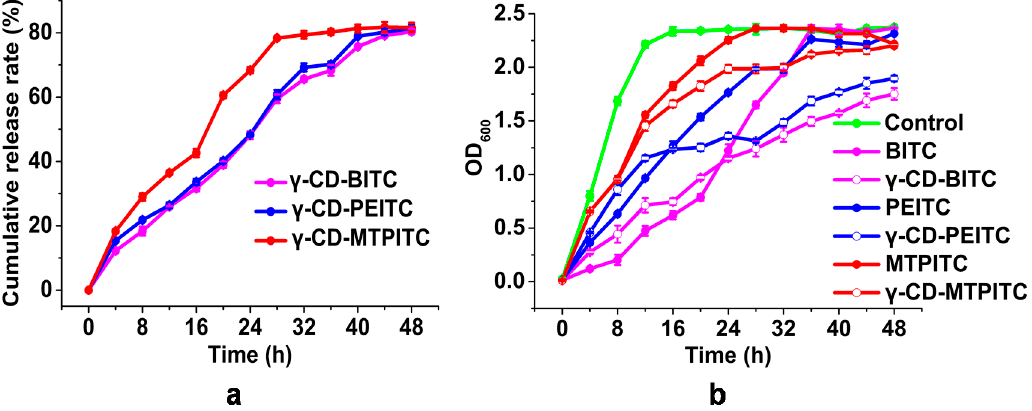
Figure 3. ( a ) In vitro release behaviors of ITCs from γ -CD-ITCs at 37 °C. ( b ) Growth curves of S. aureus treated with the control, ITC (0.25 mmol/L), and γ -CD-ITC (0.25 mmol/L ITC). Values are means ± standard deviations, indicated by error bars. Table 1. The diameters of inhibition zone of ITCs and γ -CD-ITCs against S. aureus.